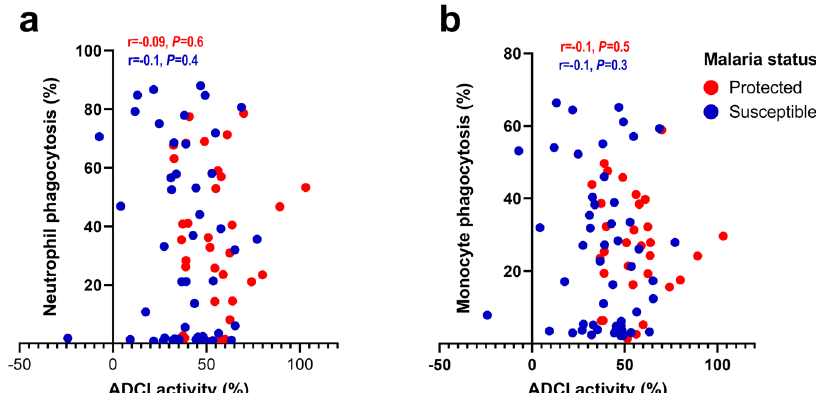
Fig. 5 ADCI activity is not associated with merozoite-phagocytosis by neutrophils or monocytes. Scatterplots showing the relationship between ADCI activity and merozoite-phagocytosis by neutrophils a and monocytes b in a Ghanaian cohort of children. Here, the data are presented for 85 children (protected [red dots] = 33, susceptible [blue dots] = 52) for whom both phagocytosis and ADCI activity were available. Spearman ’ s correlation coef fi cient r, with associated P value is shown for both protected (red font) and susceptible (blue font) children in